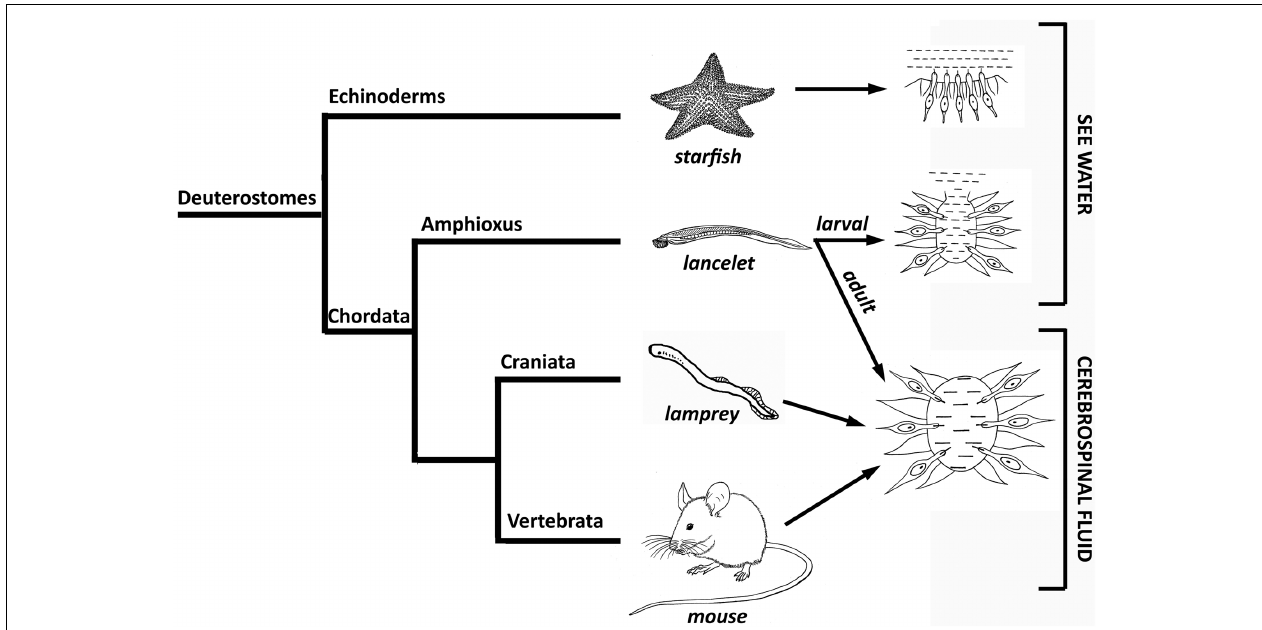
FIGURE 3 | Scheme of the evolution of the phylogenetic increase in the control that the chemical environment has over the cerebrospinal